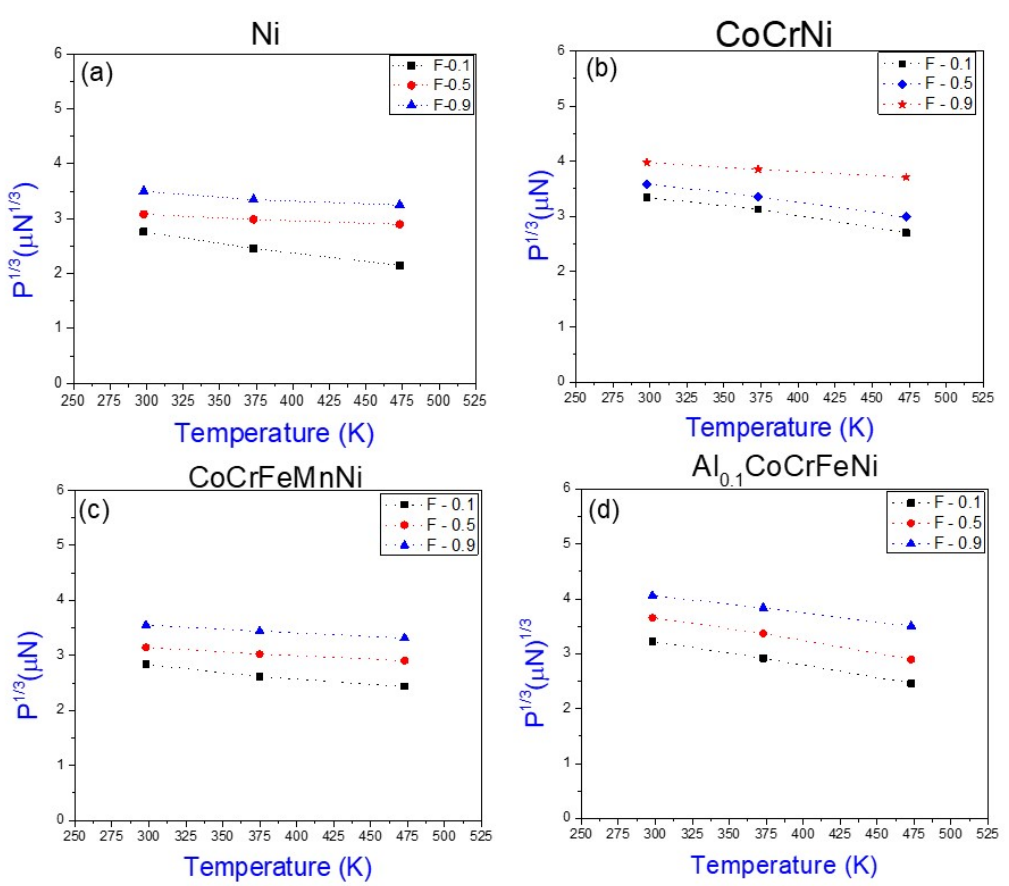
Figure 6. Plot of P 1/3 vs. T to evaluate the activation enthalpy of the first burst for ( a ) Ni, ( b ) CoCrNi, ( c ) CoCrFeMnNi, and ( d ) Al 0.1 CoCrFeNi alloys.